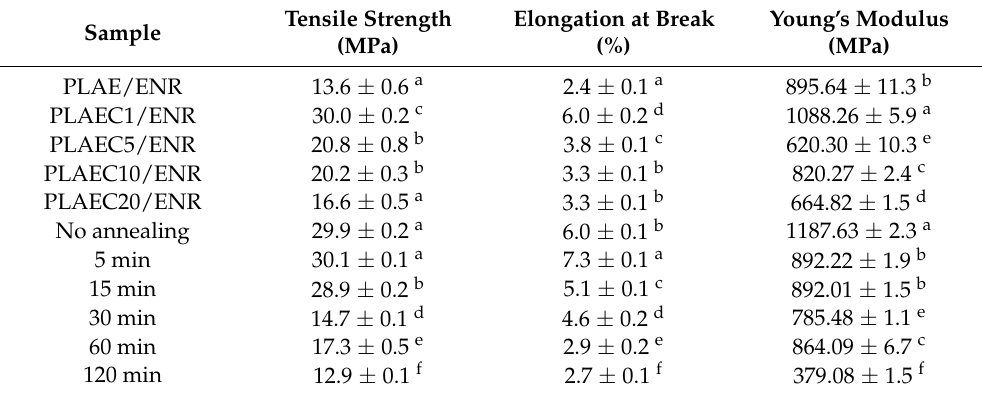
Figure 4. Tensile strength and elongation at break of ( a ) PLA and PLAEC/ENR blend with different CTS contents and ( b ) PLAEC1/ENR blend with different annealing times (0–120 min) at 80 ◦ C. Table 2. Tensile properties of PLA, epoxy resin, CTS, and ENR blend, and the PLAEC1/ENR blend with annealing times of 0–120